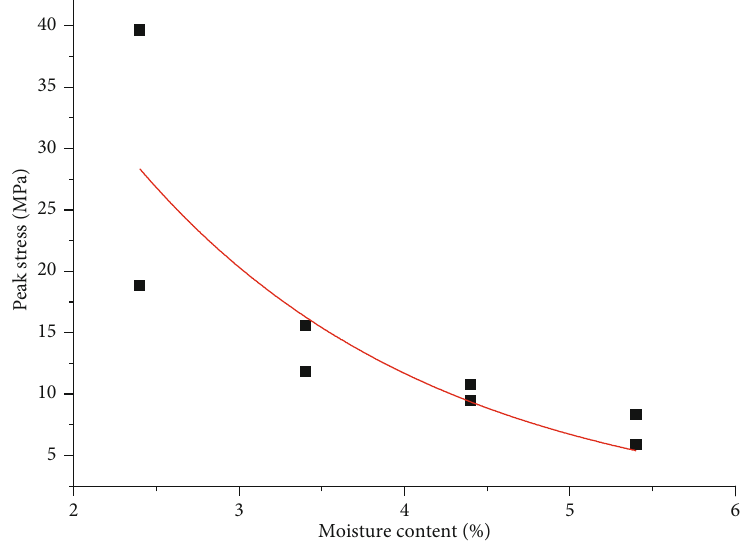
Figure 11: Water content-peak stress evolution diagram of